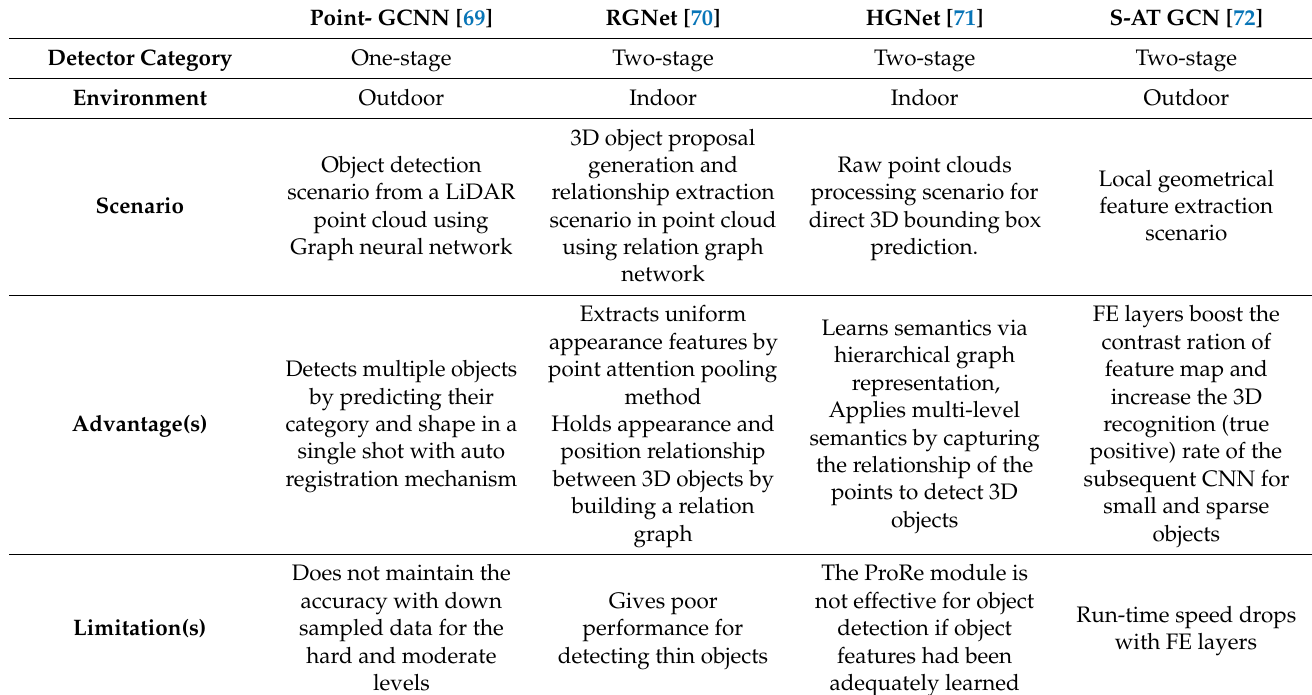
Figure 19. The pointPillars [72] with a feature enhancement layer. Table 16. Literature Analysis: Graph-based Representation for